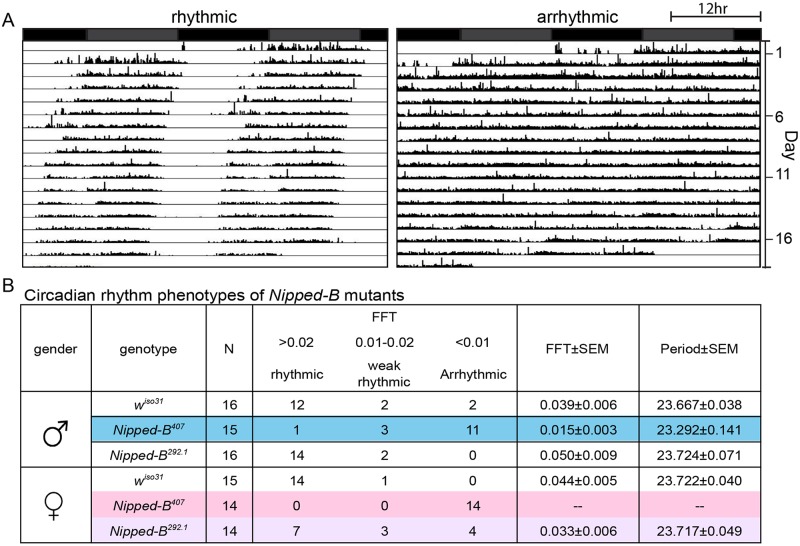

Nipped-B heterozygous mutants are arrhythmic.Flies were placed in constant darkness (DD) for over 14 days to record their locomotor activities, which were used to determine free-running rhythms. (A) Representative double plotted actograms are shown. Rhythmic flies show a robust rest/activity dichotomy, which is absent in arrhythmic flies. (B) Summary of circadian rhythm behaviors of Nipped-B mutants. Numbers of flies in each rhythmicity group are shown and N refers to the total numbers of flies tested. Rhythmicity was decided upon analysis of actogram, periodogram and FFT value. Significantly different from w
iso31 controls, most Nipped-B
407 males and all Nipped-B
407 females are arrhythmic (p = 0.001 for mutant versus control males shaded in blue, p = 0.001 for mutant versus control females shaded in pink, using Fisher’s exact test, low average FFT value). Nipped-B
292.1 females also show a slightly weaker rhythmicity than w
iso31 females (p = 0.042, Fisher's exact test, low average FFT value, shaded purple). FFT average and Periods were calculated from flies of the rhythmic and weak rhythmic groups. Periods of all genotypes were in the wild-type range (~23.5hr). SEM: standard error. FFT: fast Fourier transform value.